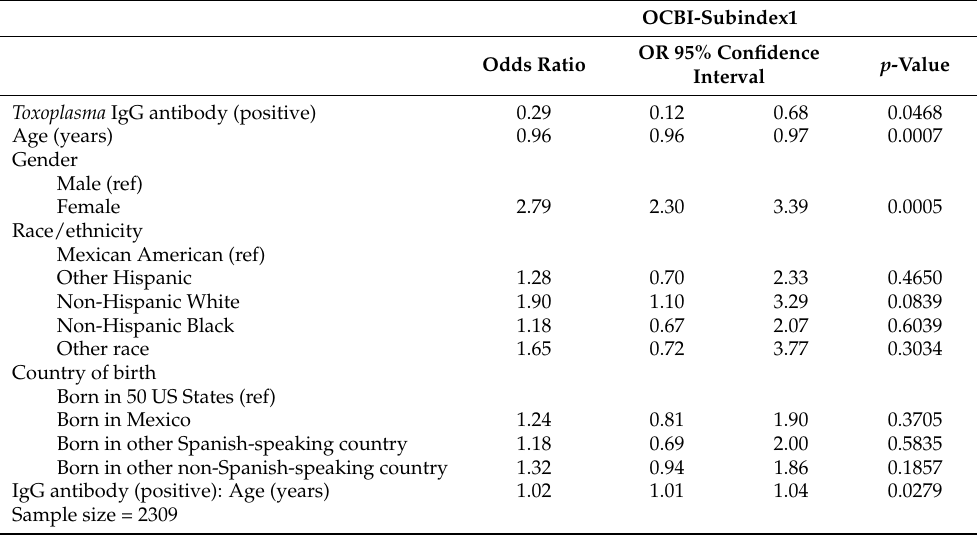
Table 9. Ordinal logistic regression model for the OCBI-Subindex1 on T. gondii IgG antibody (posi- tive/negative) adjusted for the demographic factors.